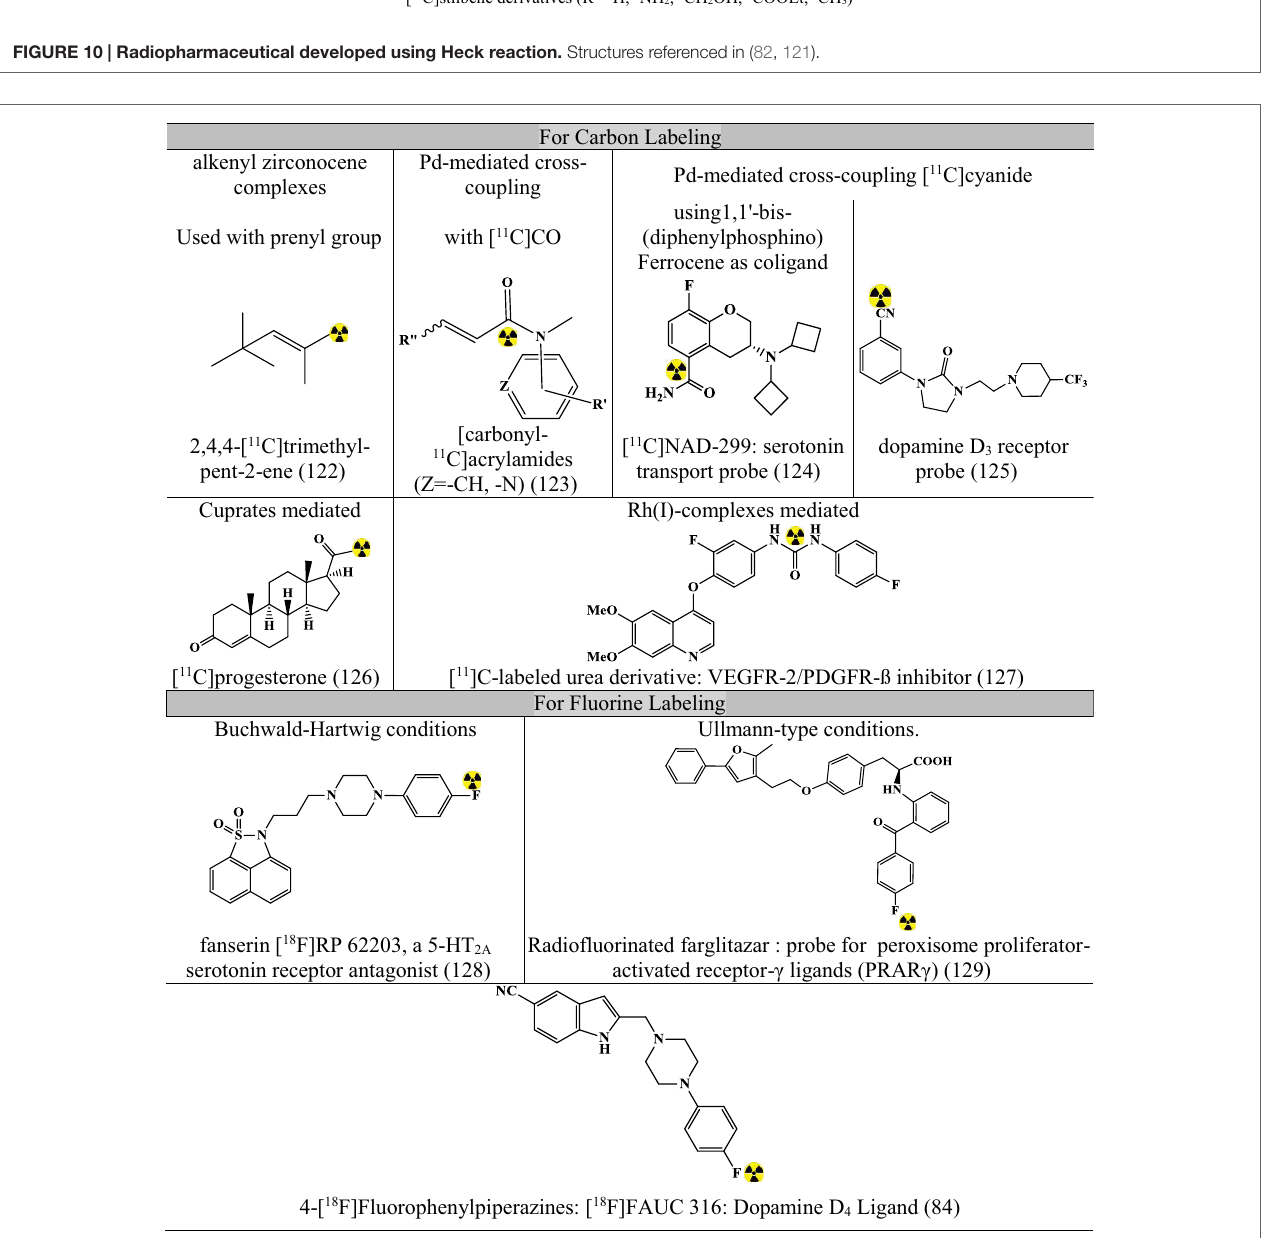
FiGURe 11 | Representative radiopharmaceuticals developed using Misc reactions. Reference: (80, 82, 84,